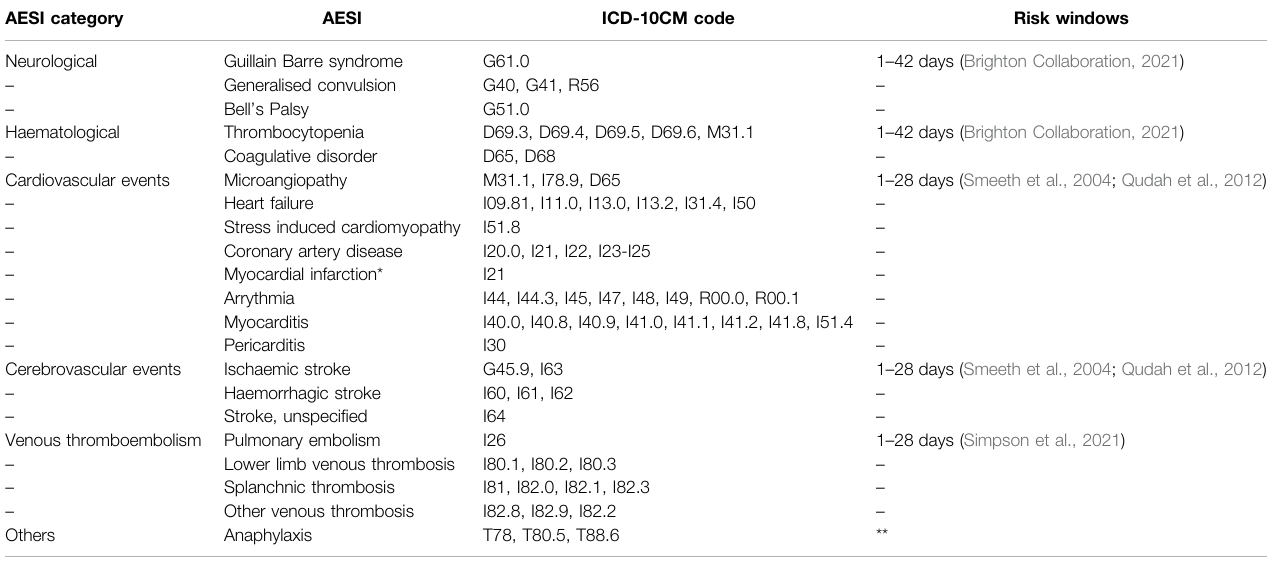
TABLE 1 | International Classi fi cation of Diseases, Tenth Revision, Clinical Modi fi cation (ICD-10CM) codes for pre-speci fi ed Adverse Events of Special Interest and recommended risk